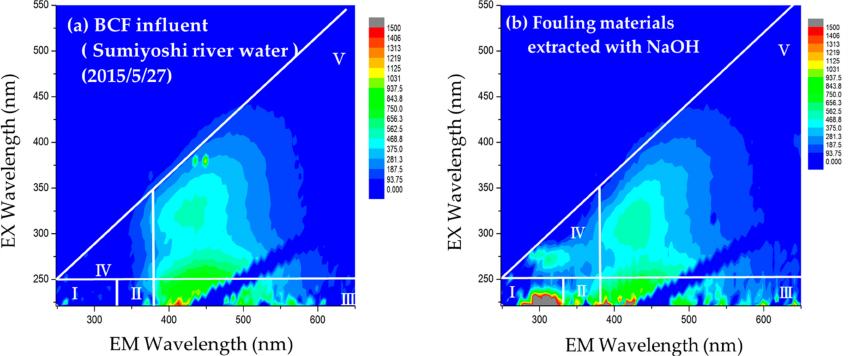
Figure 2. Excitation and emission matrix of ( a ) biological contact filter (BCF) influent and ( b ) fouling material extracted with NaOH. I: Aromatic Protein I; II: Aromatic Protein II; III: Fulvic acid-like; IV: Soluble microbial by-products; V: Humic